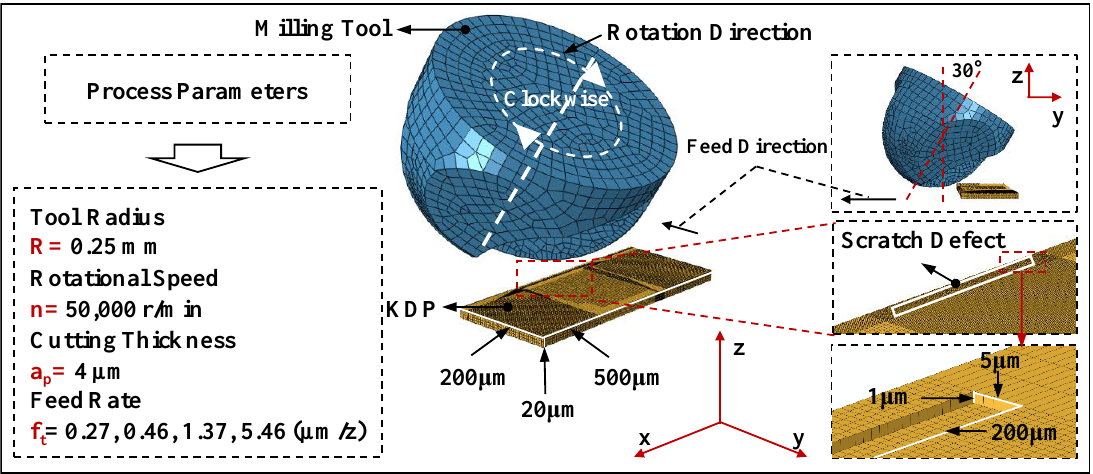
Figure 1. The schematic of the established 3D simulation model of KDP micro-milling process.